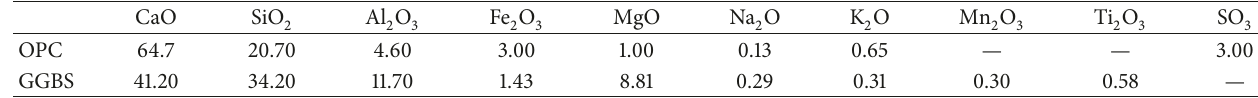
Figure 1: Schematic for steel (a), electrochemical chloride extraction of concrete (b), and electrochemical measurement of corrosion behaviour (c). Table 1: Oxide composition of binders.